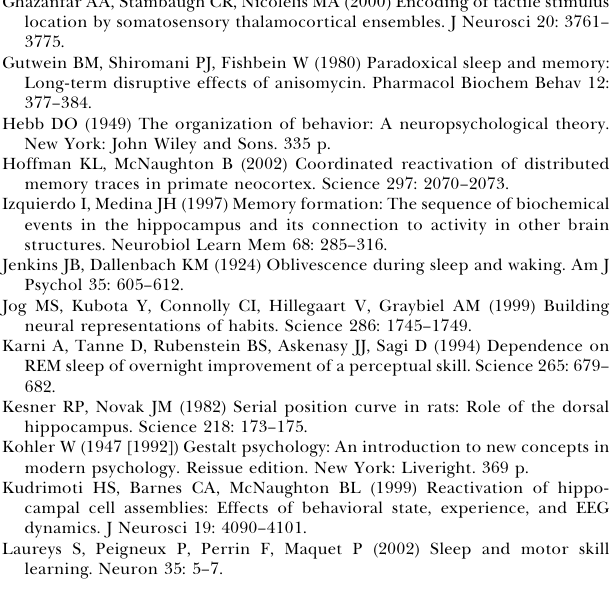
Figure S7. Recording LFPs and